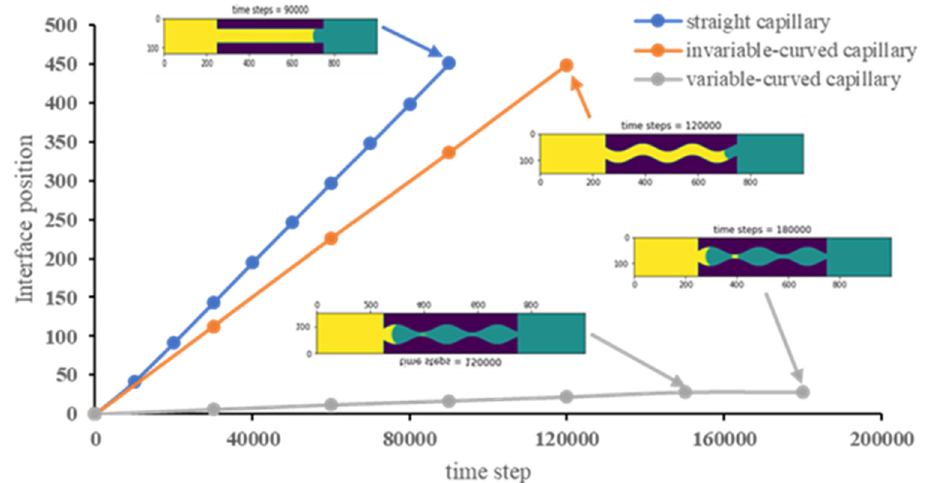
Figure 15. The spontaneous imbibition of three types of capillaries.